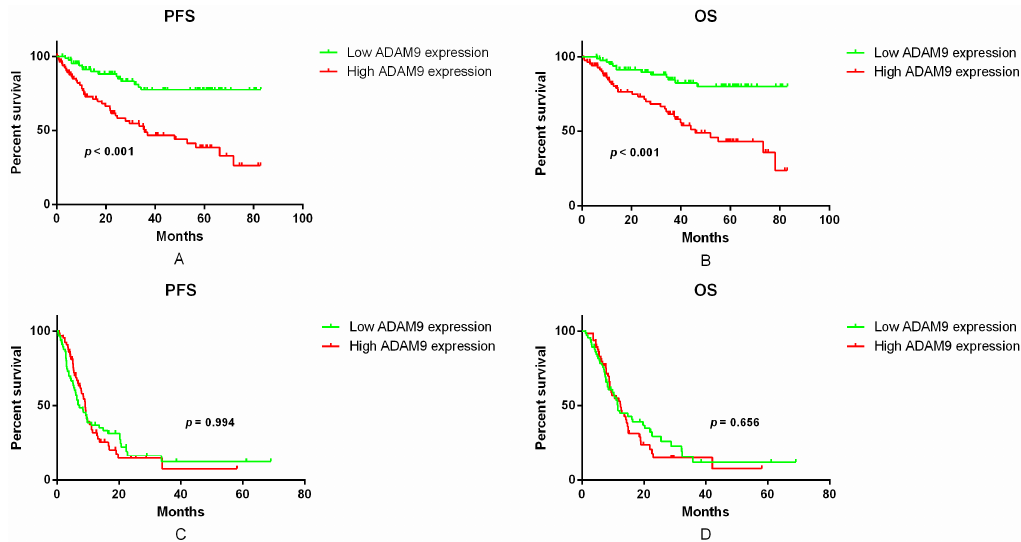
Figure 3. Kaplan–Meier survival analysis of different grades of glioma patients based on ADAM9 expression. ( A ) Comparison of the PFS between ADAM9 high and low expression group in patients with LGG tumors ( p < 0.001, log-rank test); ( B ) Comparison of the OS between ADAM9 high and low expression group in patients with LGG tumors ( p < 0.001, log-rank test); ( C ) Comparison of the PFS between ADAM9 high and low expression group in patients with GBMs ( p = 0.994, log-rank test); ( D ) Comparison of the OS between ADAM9 high and low expression group in patients with GBMs ( p = 0.656, log-rank test). PFS, Progression-free survival; OS, overall survival; LGG, lower-grade glioma; GBM, glioblastoma.